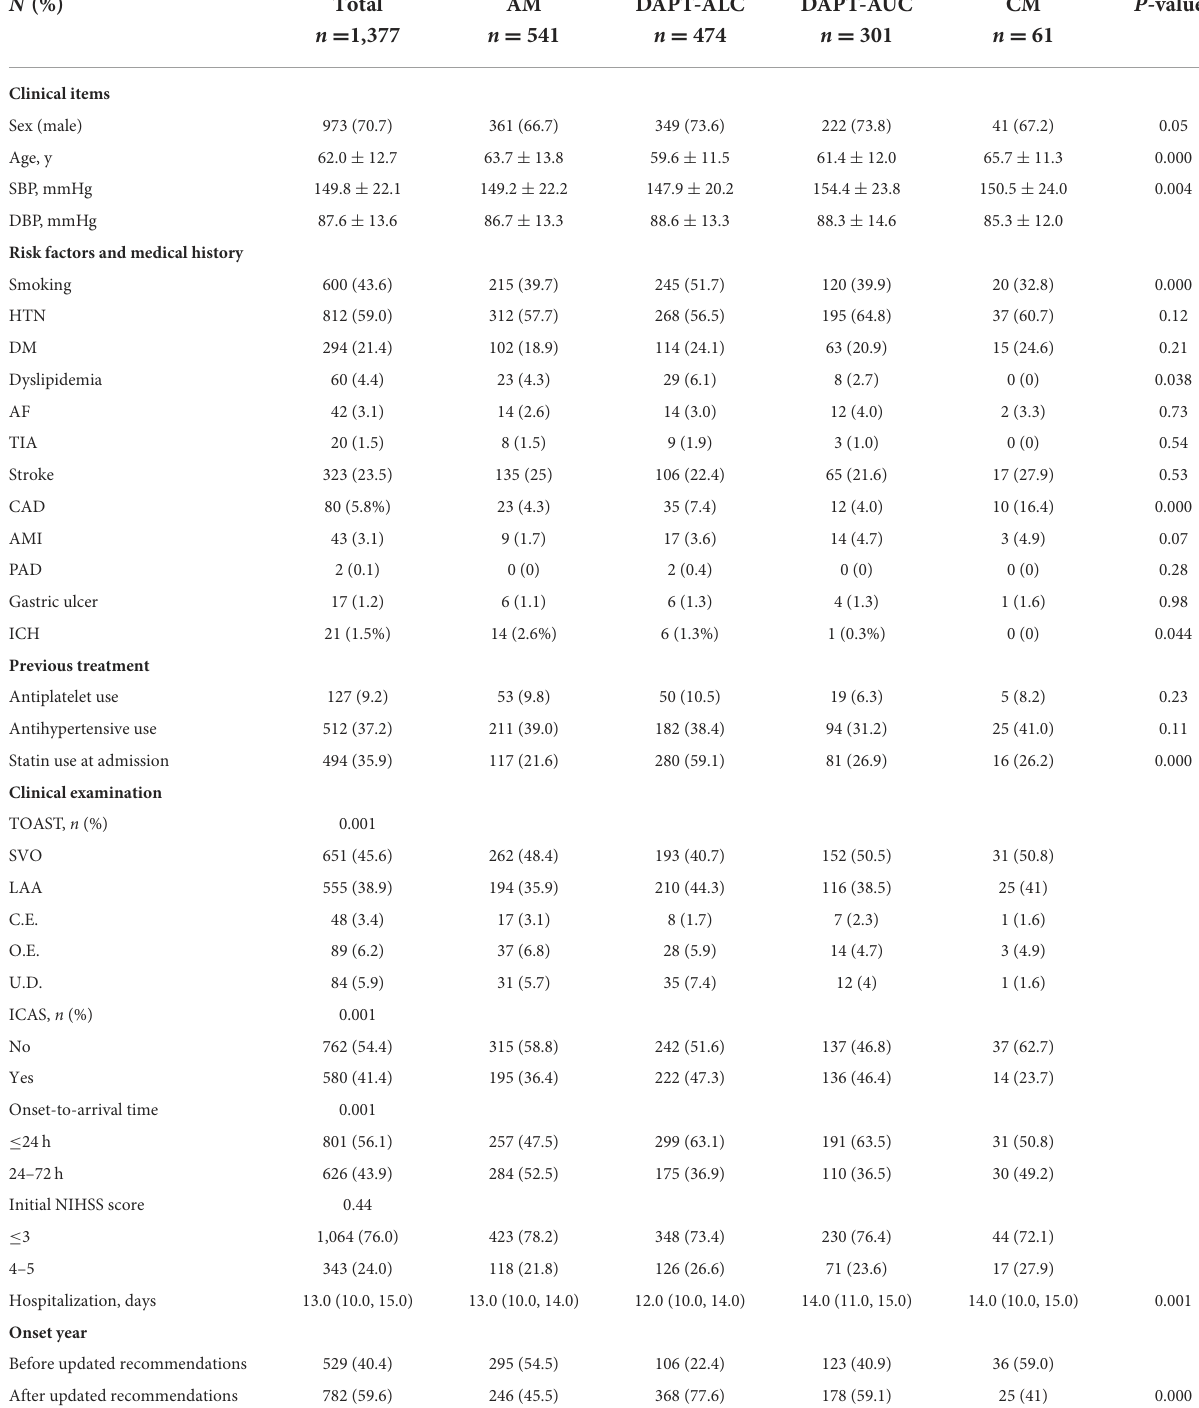
TABLE 1 Comparison of clinical characteristics according to different antiplatelet therapy